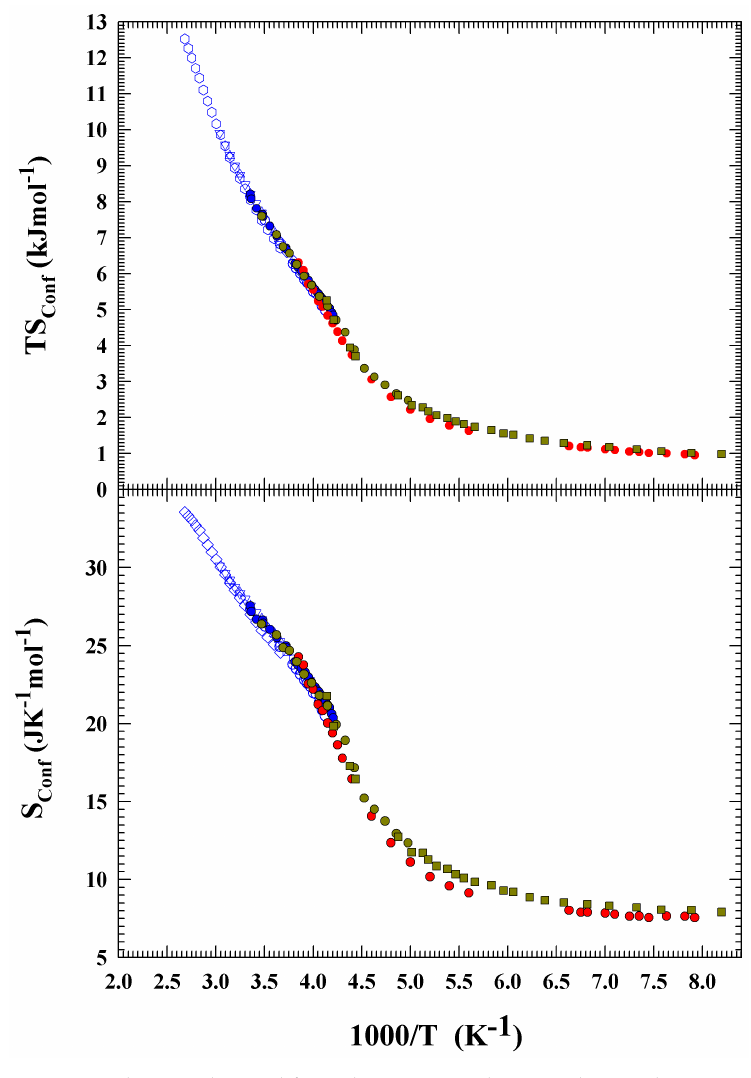
Figure 5. The TS Conf and S Conf obtained from the transport data acording to the AG equation, in the top and bottom panels, respectively.